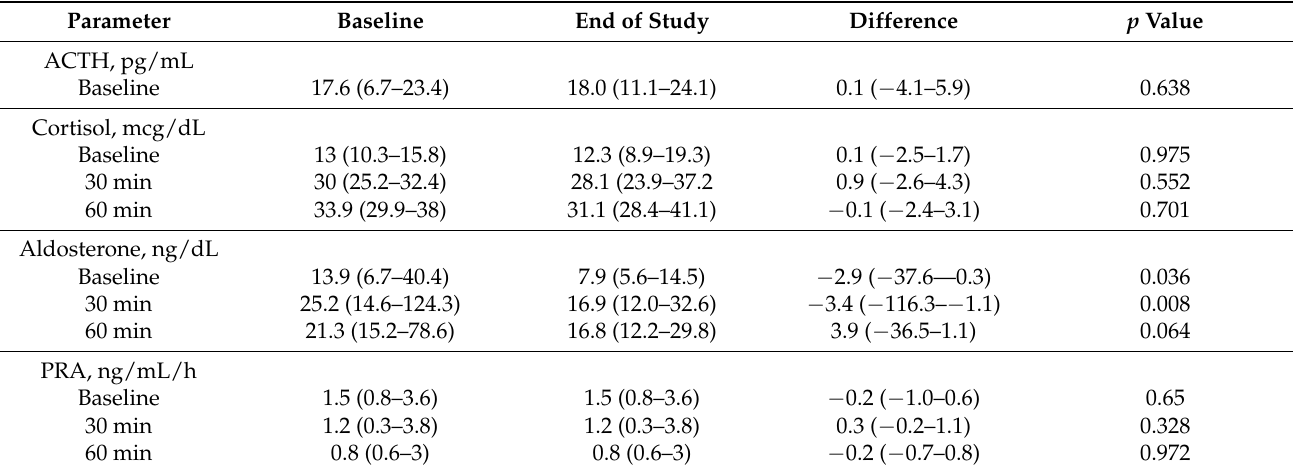
Table 3. Results of the 250 mcg ACTH stimulation test.